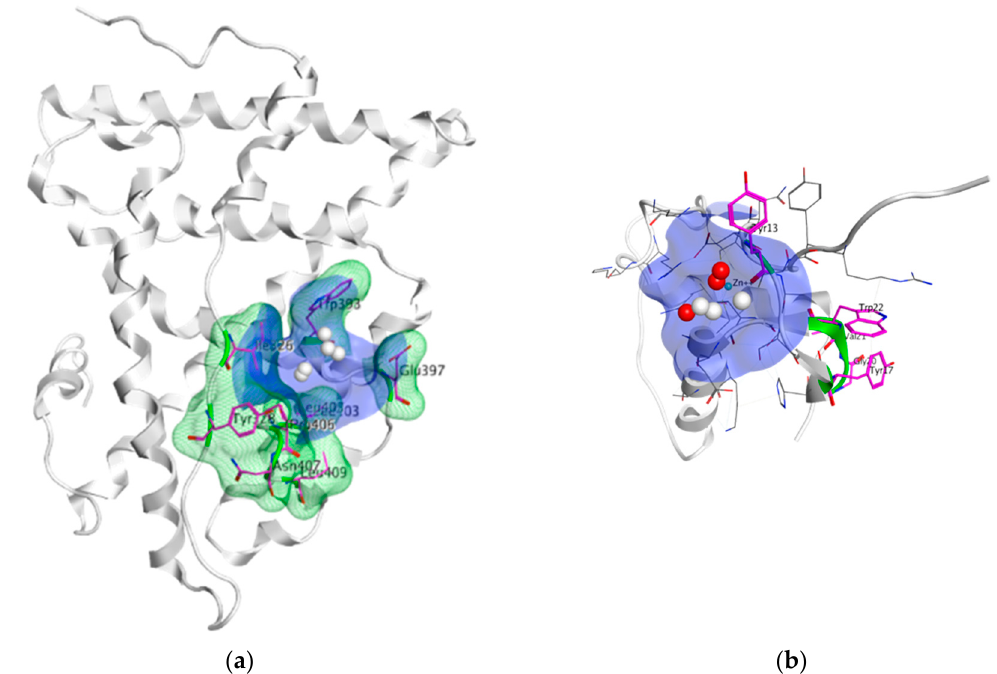
Figure 17. ( a ) The important residues (green surface, pink atoms) of ER-LBD that interact with ER-DBD. The identified binding site is shown in blue. ( b ) The important residues (green ribbon, pink atoms) of ER-DBD interacting with ER-LBD.